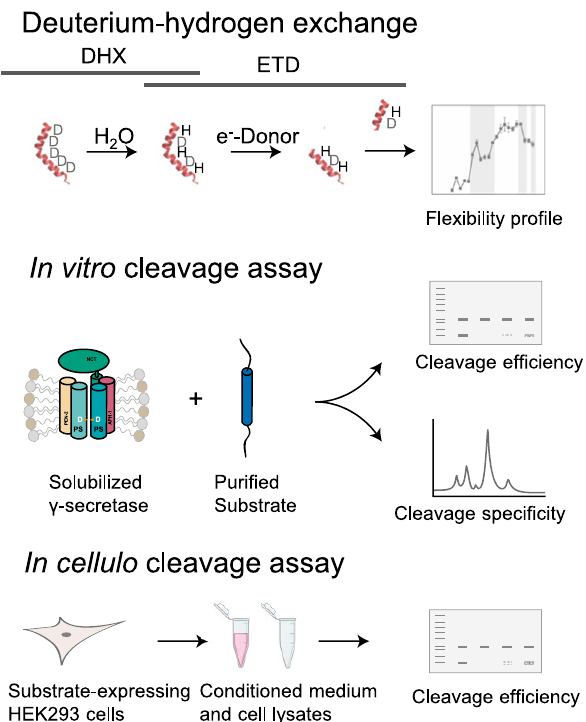
Fig. 1 Outline of experimental strategy. The mechanism of cleavage was delineated based upon deuterium-hydrogen exchange analysis, combined with in vitro and in cellulo cleavage